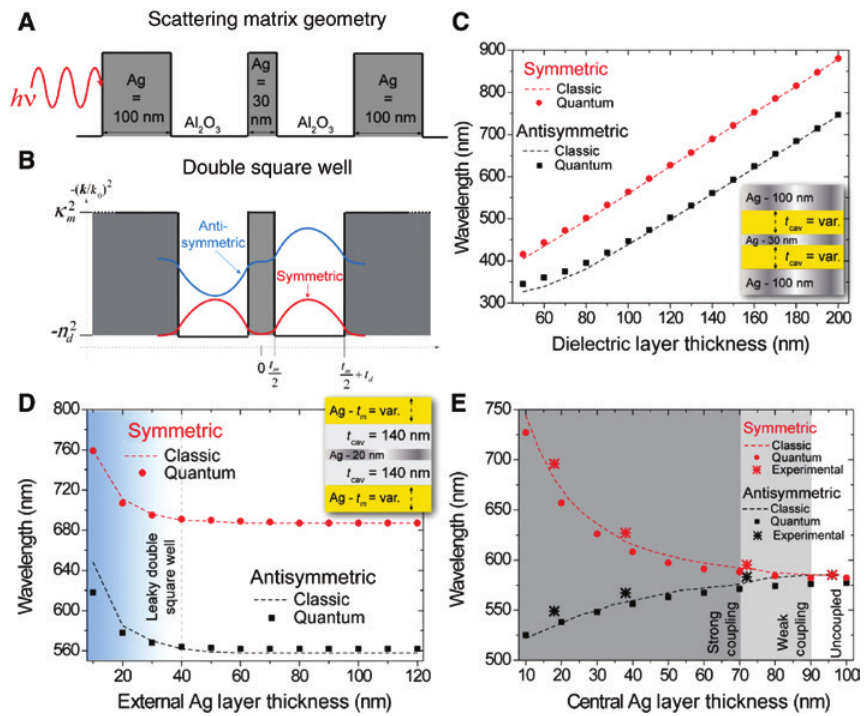
Figure 4: Quantum mechanical model of the MIMIM cavity. (A) Structure of a MIMIM with thick external metal layers as used for SMM calculations. (B) Double quantum well that is the quantum mechanical analogue of the MIMIM structure. The y -scale for the optical potential is –( k / k ) 2 , and the origin of the x -axis is chosen in the 0 middle of the central barrier. The barrier height of the potential for the photons induced by the metal layers is given by the square of the . n − (C and D) Resonance frequencies calculated with imaginary part of the refractive index 2 , κ whereas the potential in the dielectric is at 2 d m the quantum approach (markers) and numerical SMM simulations (dashed lines) for different thickness of the dielectric layers (C) and the external Ag layers. (E) Experimental (large markers), quantum calculated (small markers), and SMM simulated resonance wavelengths of MIMIM structures with different central metal layer thicknesses. The mode splitting can be tuned from uncoupled resonators, through weak coupling, into the strong coupling regime. The largest experimental mode splitting is 477 meV for a central metal layer thickness of 18 nm, which is among the highest values reported in the literature [12, 13,